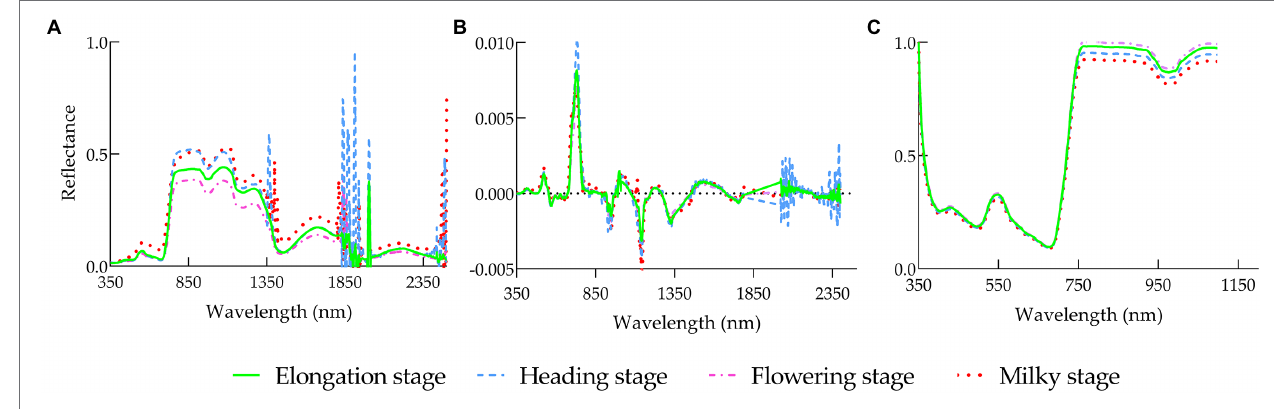
FIGURE 4 | Spectral reflectance of rice leaf canopy under different treatments in various growth stages: (A) OR, (B) FD, (C) CR.